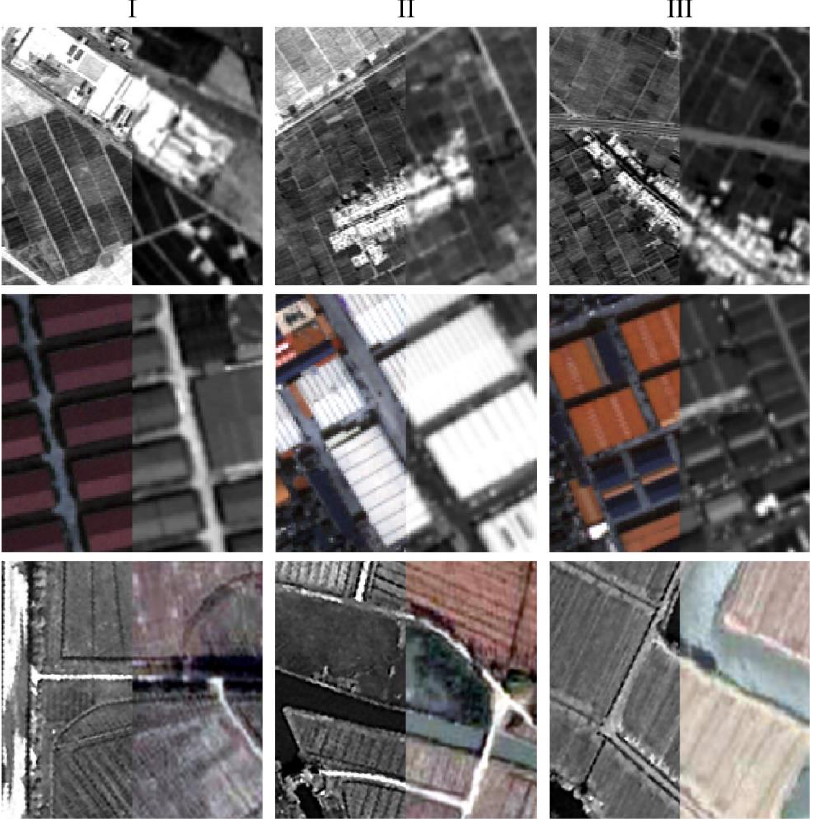
Figure 8. Enlarged subsets of the reference images and warped sensed images corresponding to the boxes I , II , and III in Figure 7.